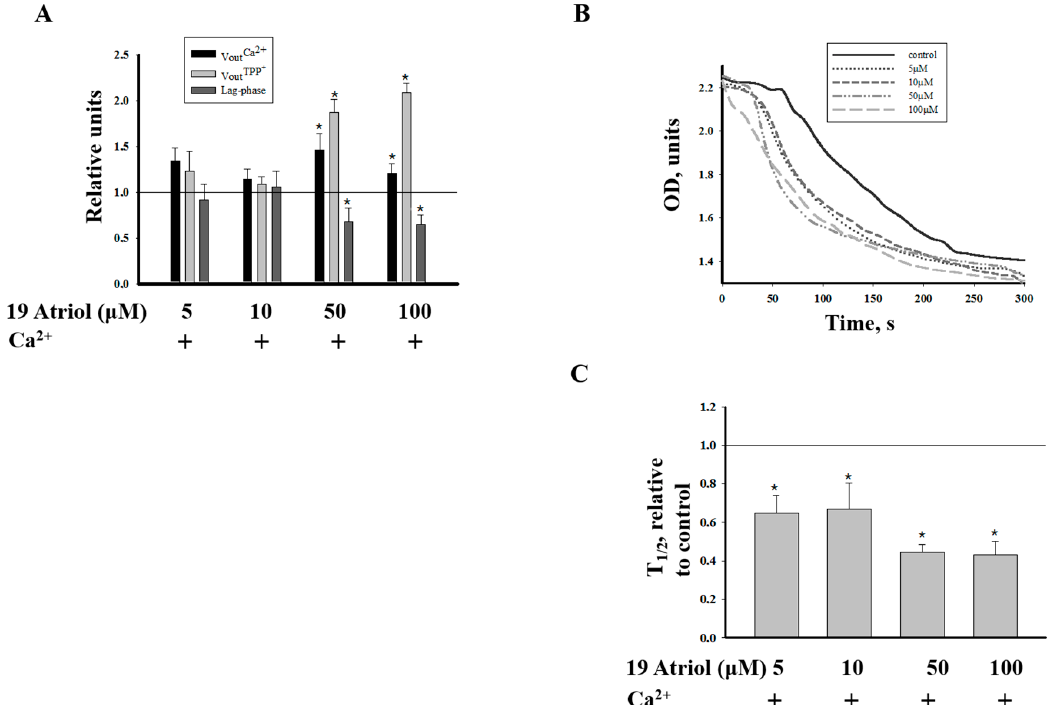
Figure 2. Concentration dependence of 19-Atriol on the parameters of RLM (rat liver mitochondria) functions. ( A ) Quantitative characteristics of parameters of RLM functions; ( B ) The high-amplitude swelling of RLM in the presence of different concentrations of 19-Atriol; ( C ) The average results of the half-time (T 1/2 ) to reach the maximal swelling of RLM. Lines in ( A ) and ( C ) show swelling of RLM under control conditions. This parameter was calculated as described in [26]. A value of p < 0.05 was considered to be significant (asterisk indicates p < 0.05).